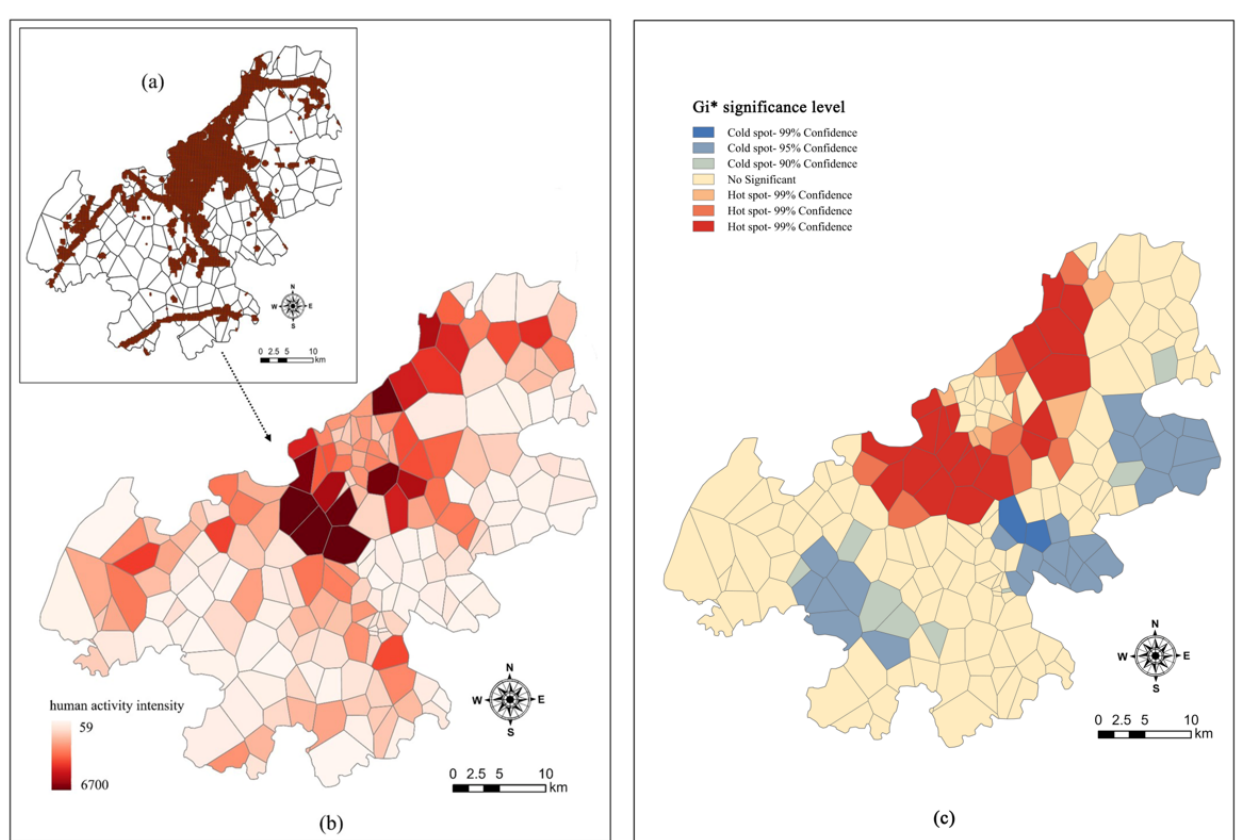
Figure 5. Spatial pattern diagram of human activities in Jiangning District, ( a ) Vectorized Baidu Heat Map, ( b ) Spatial distribution of human activity intensity, ( c ) Spatial distribution map of cold and hot spots of human activities.